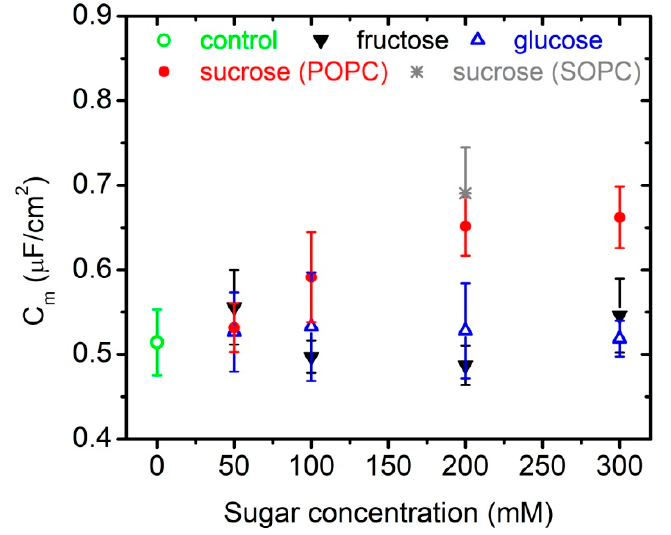
Figure 2. Specific capacitance of (i) POPC bilayers in the presence of 1 mmol/L NaCl and up to 300 mmol/L of glucose, fructose or sucrose; (ii) SOPC membranes in 1 mmol/L NaCl, 200 mmol/L of sucrose obtained from electrodeformation of GUVs. Table 1. Specific capacitance of POPC membranes in aqueous solutions containing different con- centrations up to 300 mmol/L glucose, fructose or sucrose; data obtained from electrodeformation of GUVs; GF, goodness of fit. The errors in 𝐶̅ (cid:3040) and 𝐶 (cid:3040) are standard deviations. Sugar, mmol/L